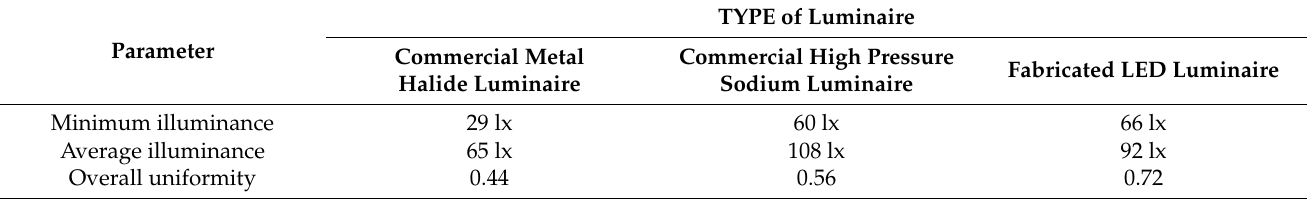
Table 5. Simulation results of light distribution considering real dimensions (150 m × 150 m) of seaport installation.